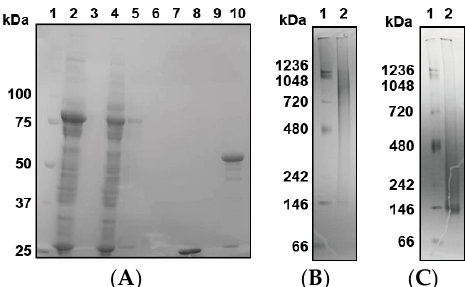
Figure 1. Expression, reconstitution, and purification of PfPV1-Strep. ( A ) SDS-PAGE analysis of GST-PfPV1-Strep expression in Escherichia coli and purification (1. Marker; 2. Supernatant of cell lysate; 3.